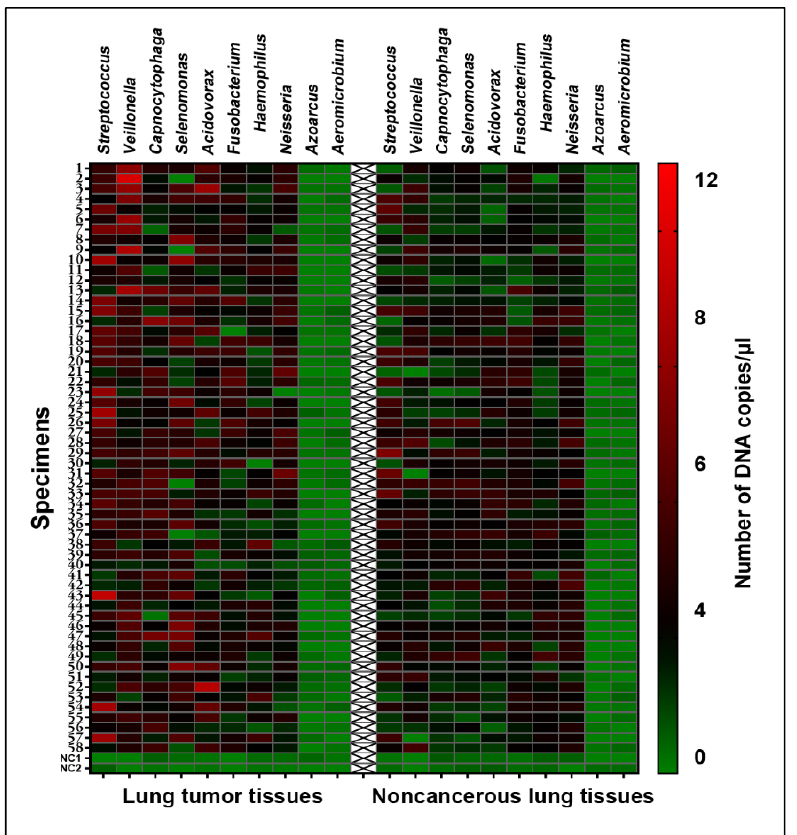
Figure 1. Heatmap of ddPCR analysis of DNA abundances of eight lung cancer-associated bacte- rial genera and two contaminant genera in 58 pairs of lung tumor tissues and noncancerous lung tissues, as well as negative control specimens. Columns represent DNA copy numbers/µL of bac- teria genera. The first 58 rows (1–58) represent cancer and normal lung tissues. The last two rows represent negative controls (NC 1–2) for DNA extraction and amplification, respectively. The left panel represent tumor tissues, whereas the right panel represent normal tissues.